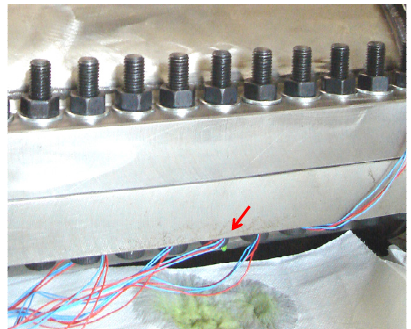
Figura 10: Prove in scala ridotta con liquido in pressione (acqua colorata). Evidenza di